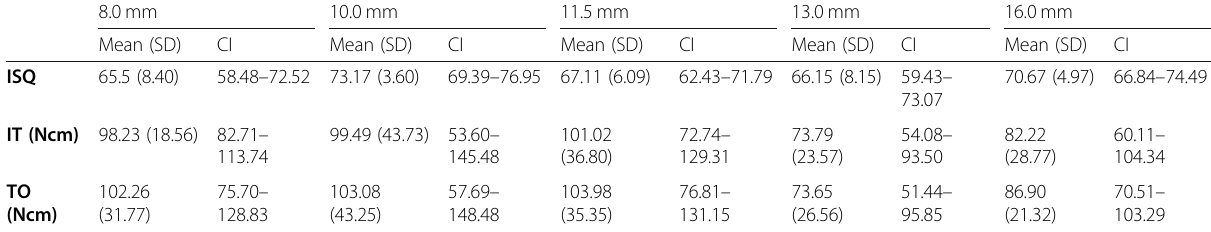
Table 4 Comparison of implant